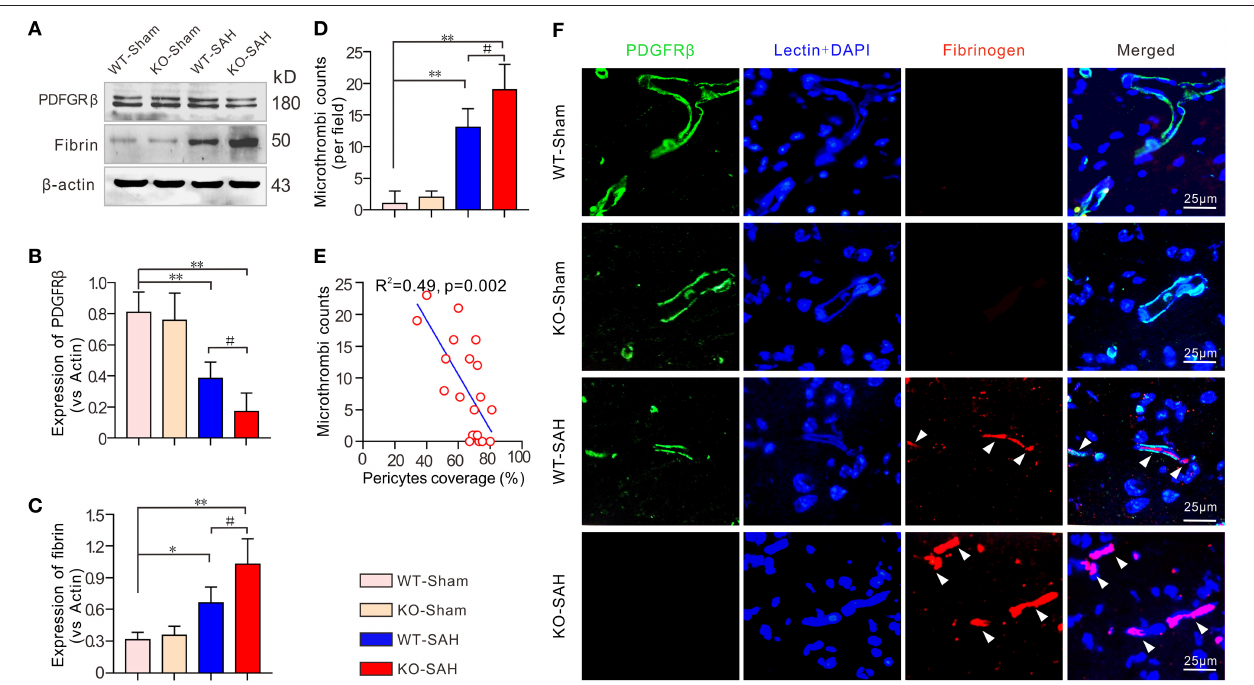
FIGURE 3 | Pericytes loss promoted icrothrombosis in ApoE-deficient mice after SAH. (A) Immunoblotting analysis of the expression of the pericytes marker PDGFR β and the microthrombi marker fibrinogen in each group. (B,C) The quantification of PDGFR β and fibrinogen. (D) Quantification of the microthrombi in each group 48h after SAH. (E) Pearson correlation test between pericytes coverage and microthrombi number in each group. (F) Immunofluorescent triple staining with lectin + PDGFR β + fibrinogen showed that microthrombi were primarily located where PDGFR β -positive pericytes were missing. Except for Pearson correlation analysis, data are expressed as the mean ± SD, one-way ANOVA with Tukey’s post hoc , * p < 0.05, ** p < 0.01, vs. the WT-Sham group; # p < 0.05, vs. the WT-SAH group; n = 5 per group; Fibrin, fibrinogen; scale bar =